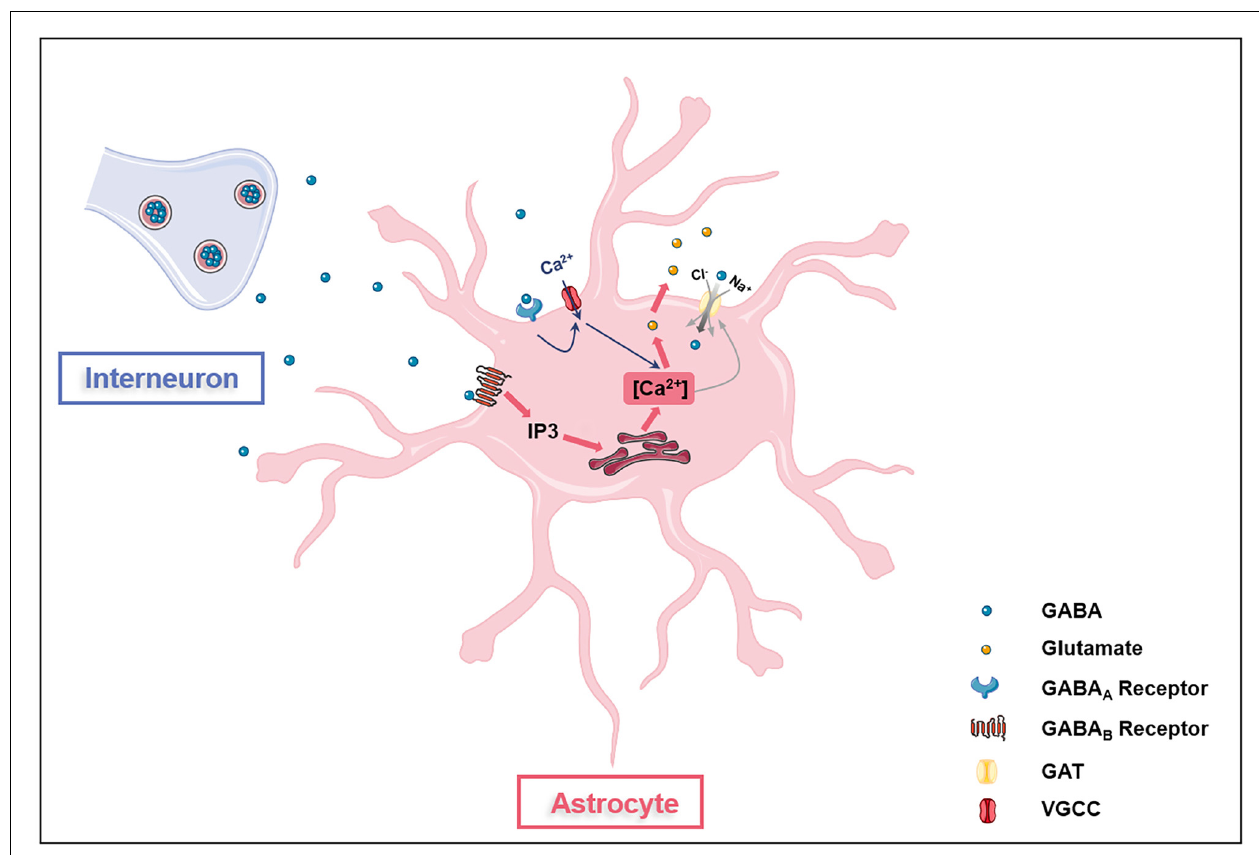
FIGURE 1 | Astrocytes are GABAceptive cells. Astrocytes express GABA A receptors (GABA A Rs), GABA B receptors (GABA B Rs), and GABA transporter proteins (GATs). Activation of GAGA A Rs on astrocytes opens voltage-gated calcium channels (VGCC), leading to the influx of extracellular Ca 2+ into the cell (blue arrow). GAGA B Rs activation induces the release of Ca 2+ from the intracellular IP3-sensitive Ca 2+ pool (red arrow). Ca 2+ oscillations in astrocytes affect glutamate release and GATs expression. GATs directly transport extracellular GABA into